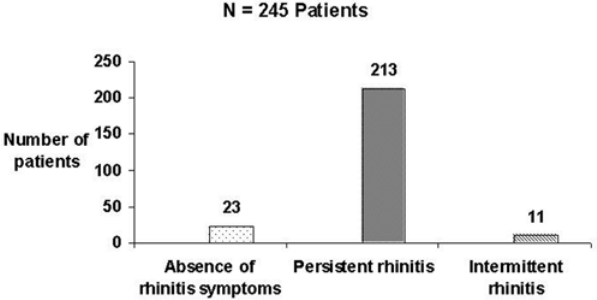
Figure 1 - Frequency of rhinitis symptoms among severe asthma patients (defined according to the criteria established in Allergic Rhinitis and its